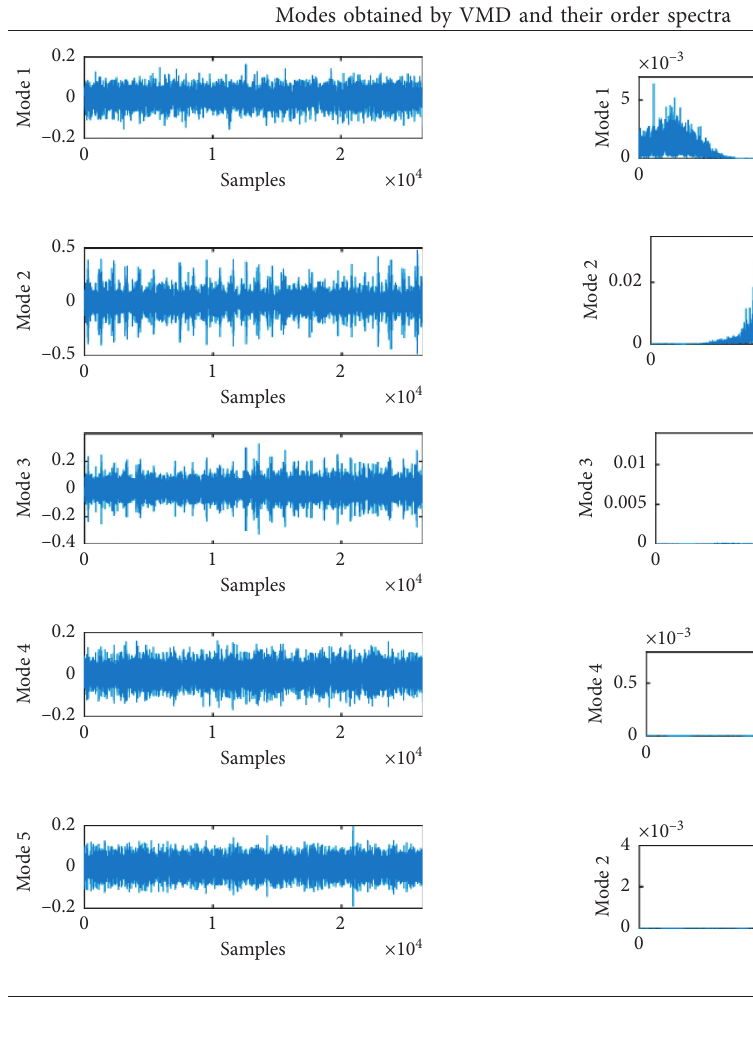
Table 8: Fitness values obtained by analyzing inner race fault signal with VMD.